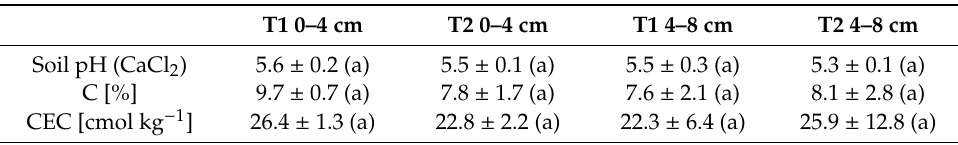
Table 3. Soil pH, %C, and CEC for T1 and